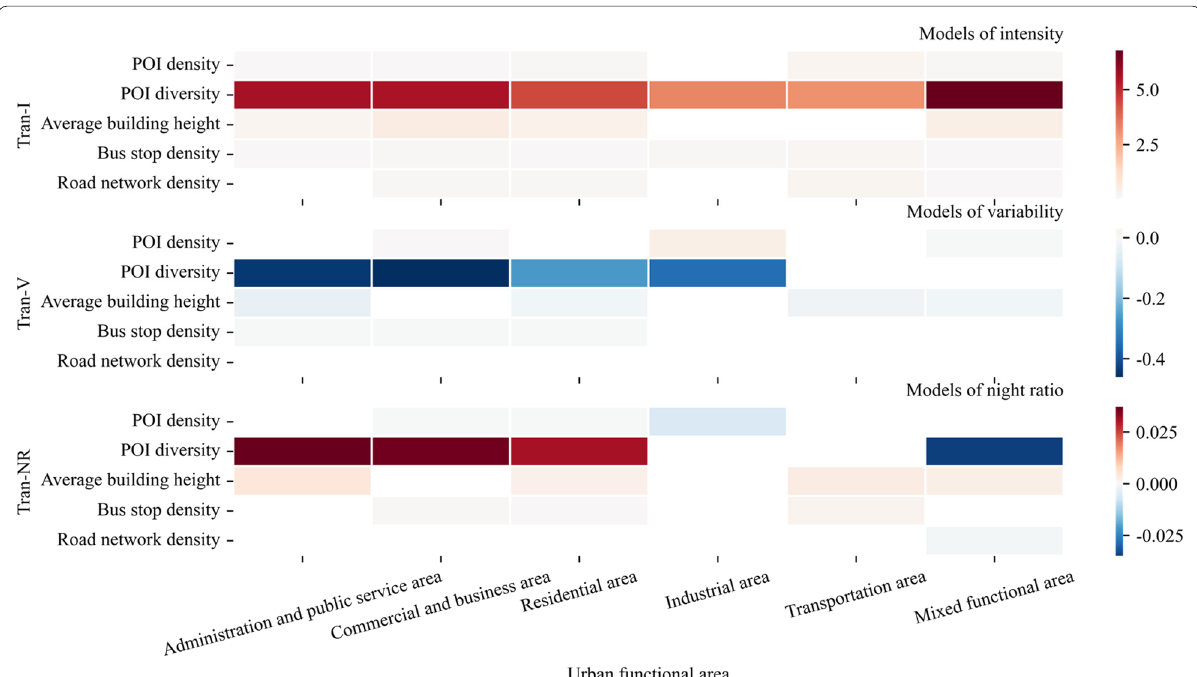
Fig. 7 Impact of the built environment on the transformed urban vitality among the various urban functional